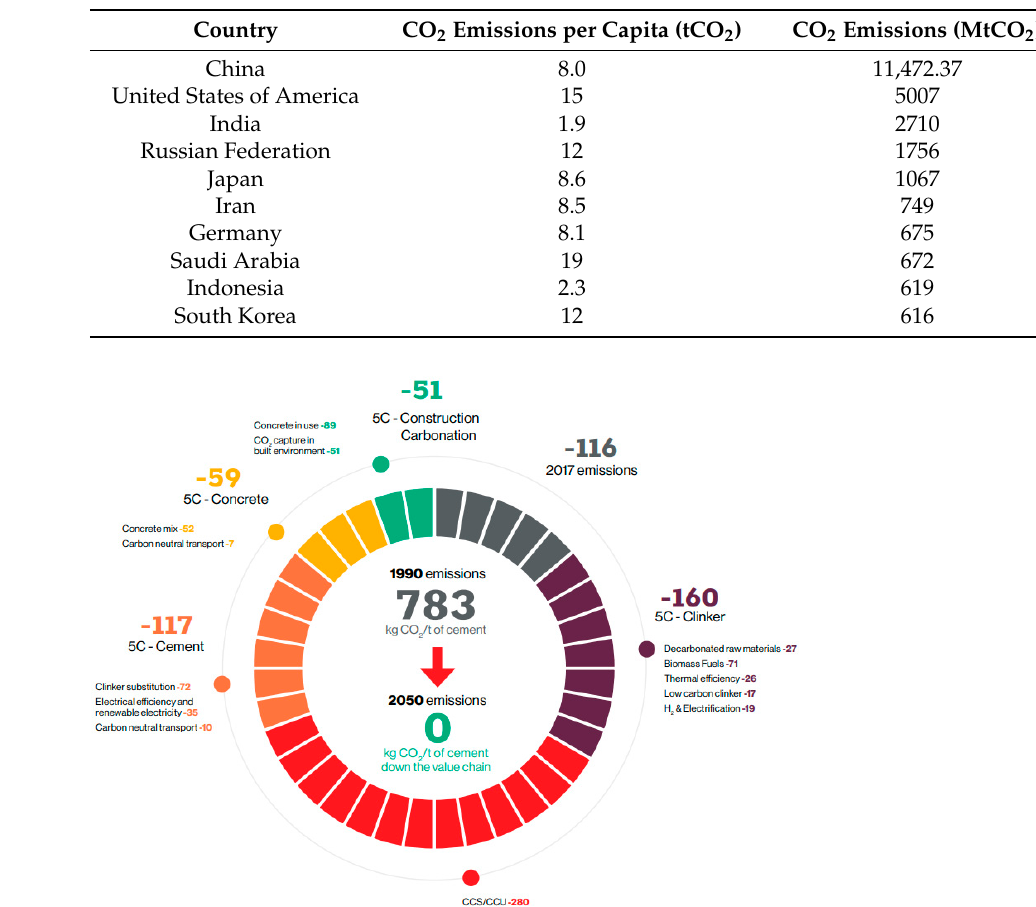
Figure 1. Carbon neutrality roadmap for the cement industry proposed by CEMBREAU [10].